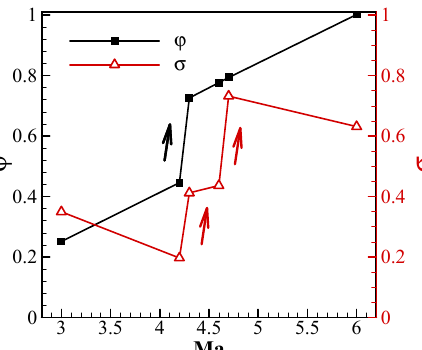
Figure 9. Distributions of mass flow ratio and total pressure recovery coefficient during the second type of starting process ( δ = 10°).